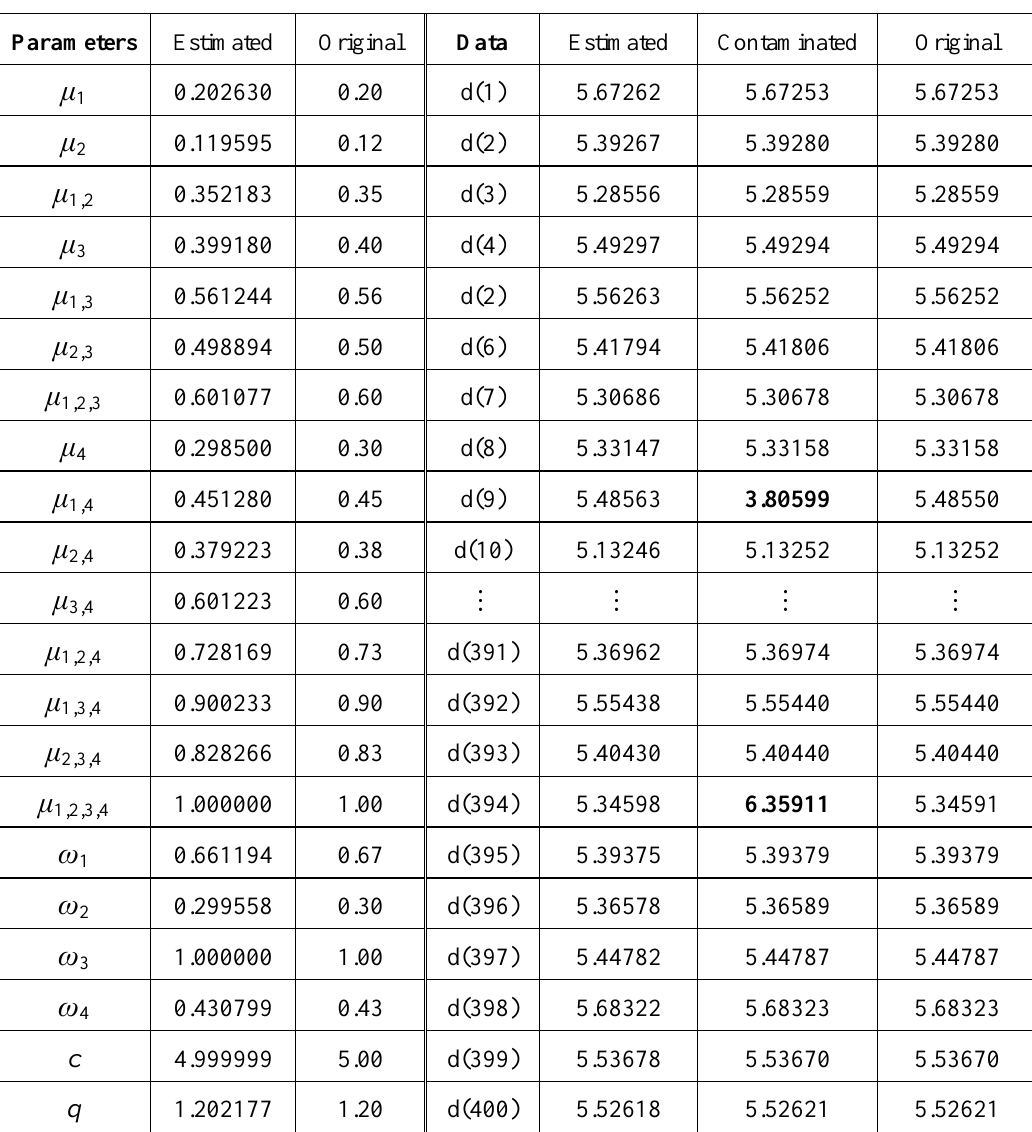
Table 2. The average results of model parameters estimated by the proposed LTS-MQPSO